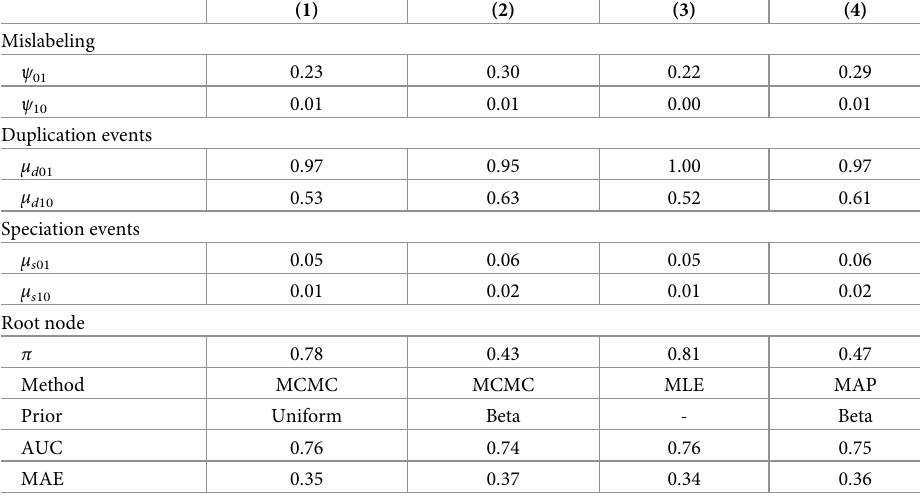
Table 4. Parameter estimates for model with experimentally annotated trees. Overall, the parameter estimates show a high level of correlation across methods. Regardless of the method, with the exception of the root node probabilities, most parameter estimates remain the same. As expected, mutation rates at duplication nodes, indexed with a d , are higher than those observed in speciation nodes, indexed with an s